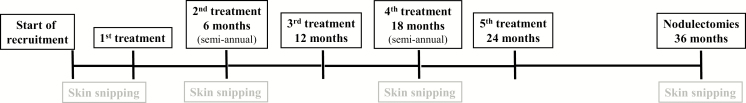
Study timeline, starting with the recruitment and ending with the surgical removal of the onchocercomata (nodulectomies) 36 months after the first treatment. In addition to the treatment time points, the figure also shows the time points when small skin biopsies (skin snipping) were taken to assess the microfilaria load in the skin.